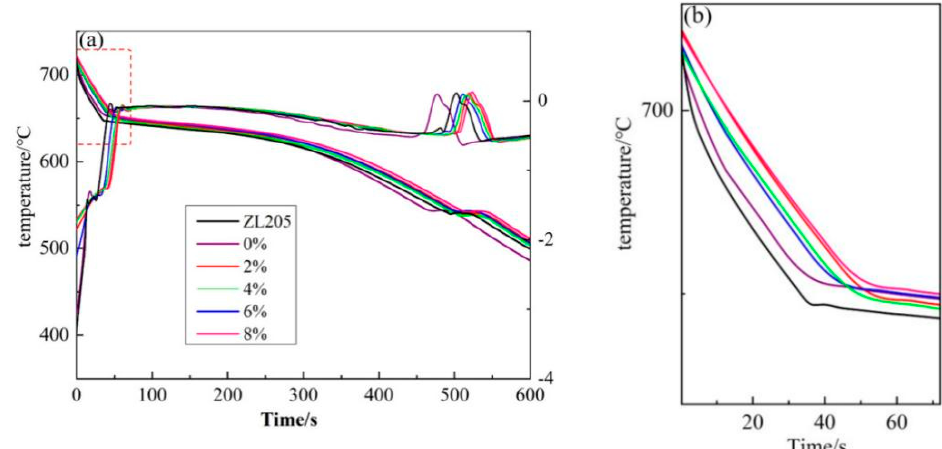
Figure 4. Thermal analysis curve of the ZL205 alloy with different erbium oxide contents. ( a ) Solidification curve and first-order differential curve. ( b ) Partial enlargement of area I.